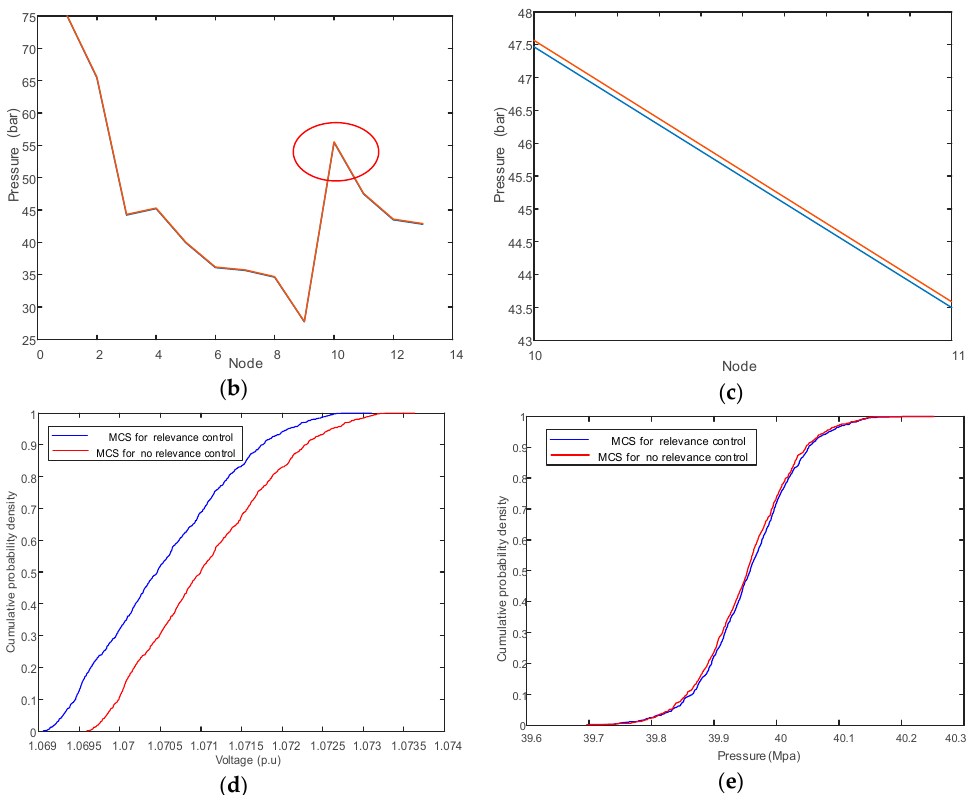
Figure 7. Comparison of Monte Carlo results with and without the Nataf transformation for Case 1. ( a ) Voltage results for each node. ( b ) Mean pressure for the natural gas network. ( c ) Enlargement of key points. ( d ) Cumulative probability of node 5 in the power network. ( e ) Cumulative probability of node 5 in the gas